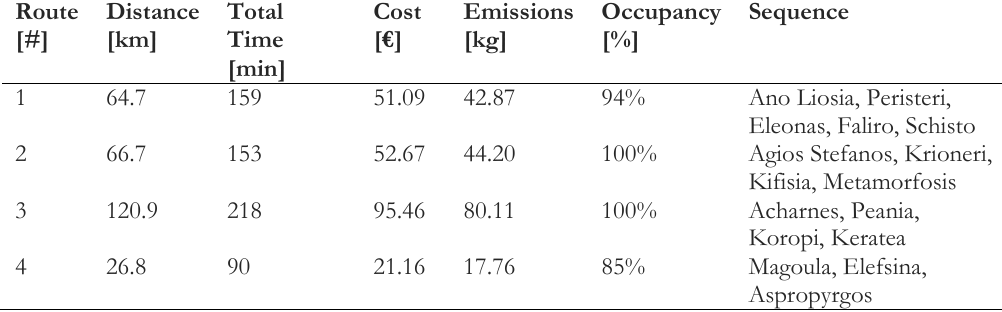
Table 5. Vehicle routing – reference scenario results.